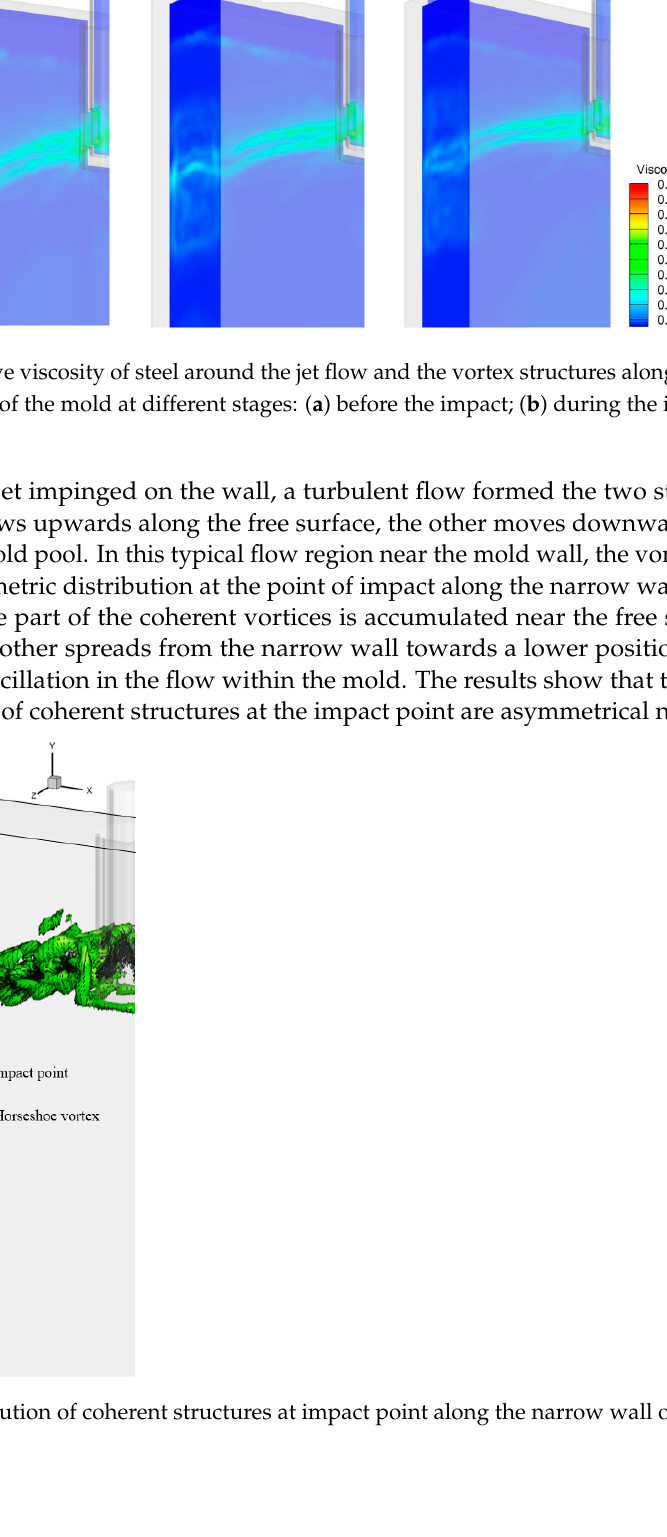
Figure 6. The transient process of the impact of the vortex structure in the jet flow at the narrow wall of the mold at different stages: ( a ) before the impact; ( b ) during the impact; ( c ) after the impact.